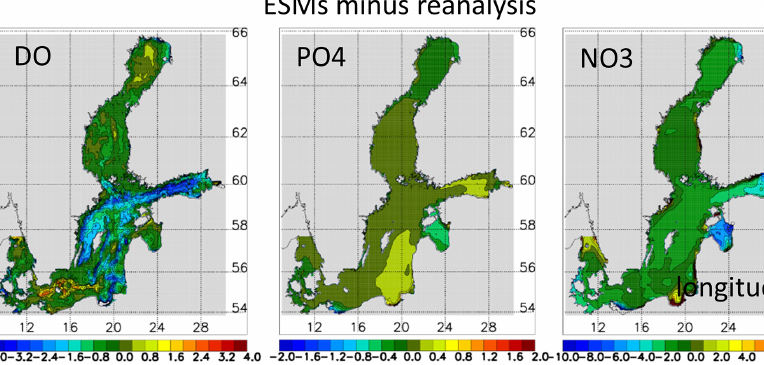
Figure 9. Upper panels: summer (June–August) mean bottom dissolved oxygen (DO) concentrations (in mLL − 1 ), winter (December– February) mean surface phosphate (PO 4 ) concentrations (in mmolPm − 3 ) and winter (December–February) mean surface nitrate (NO 3 ) concentrations (in mmolNm − 3 ) in the reanalysis data of 1976–1999 (Liu et al., 2017). Negative oxygen concentration equivalents denote hydrogen sulfide concentrations, with 1mLH 2 SL − 1 =− 2mLO 2 L − 1 . Nutrient concentrations are vertically averaged for the upper 10m. Lower panels: difference between the climatologies of the ensemble mean of the ESMs (Saraiva et al., 2019a) and those of the reanalysis data of the historical period (1976–2005). Table 7. Ensemble mean changes in sea surface temperature (SST; in ◦ C) in the ECOSUPPORT, BalticAPP RCP4.5, BalticAPP RCP8.5, CLIMSEA RCP4.5 and CLIMSEA RCP8.5 scenario simulations averaged for the Baltic Sea including the Kattegat (data sources: Meier et al., 2011b, 2021; Saraiva et al., 2019a). The changes are calculated between historical (1978–2007 in ECOSUPPORT and 1976–2005 in BalticAPP/CLIMSEA) and future (2069–2098) periods. (DJF is December, January, February; MAM is March, April, May; JJA is June, July, August; SON is September, October,